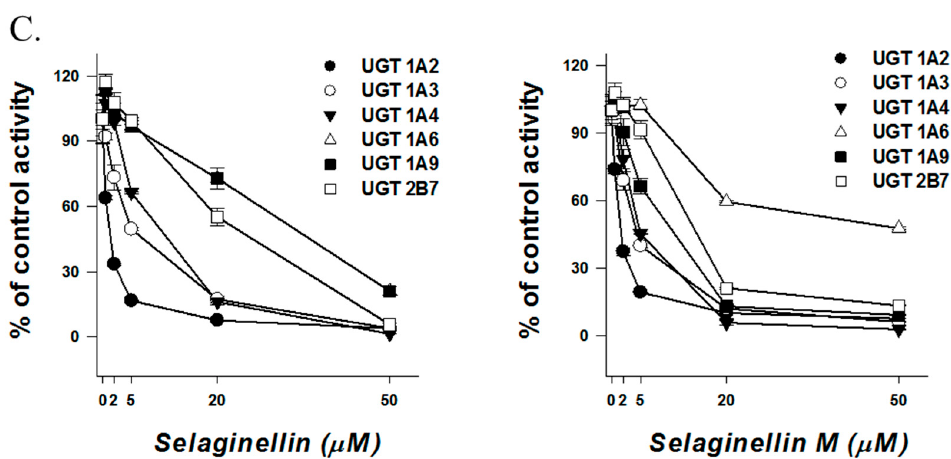
Figure 2. Inhibitory effects of selaginellin and selaginellin M against ten cytochromes P450 ( A , B ) and six uridine 5 ′ -diphosphoglucuronosyltransferase enzymes ( C ). The activity is expressed as the percentage of the control activity. The data are shown as mean ± S.D. ( n = 3). Table 1. Inhibitory effects of selaginellin and selaginellin M against ten cytochrome P450 (P450) and six uridine 5 ′ -diphosphoglucuronosyl transferase (UGT) isoforms. Compound